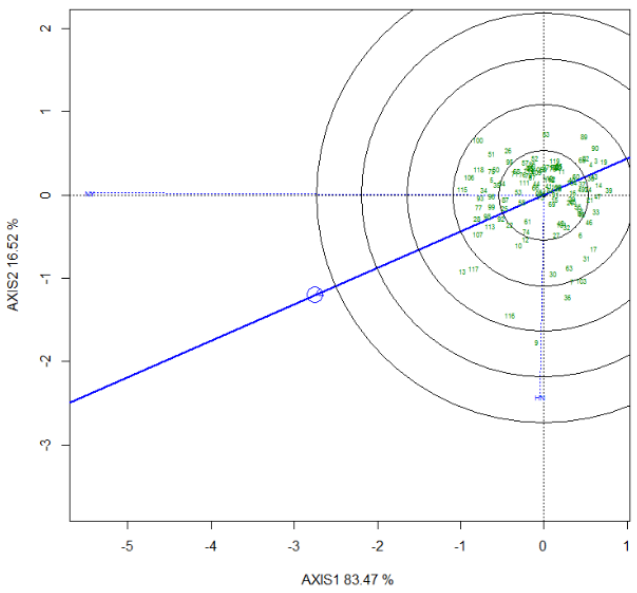
Figure 5. Ground diameter discrimination and representativeness.